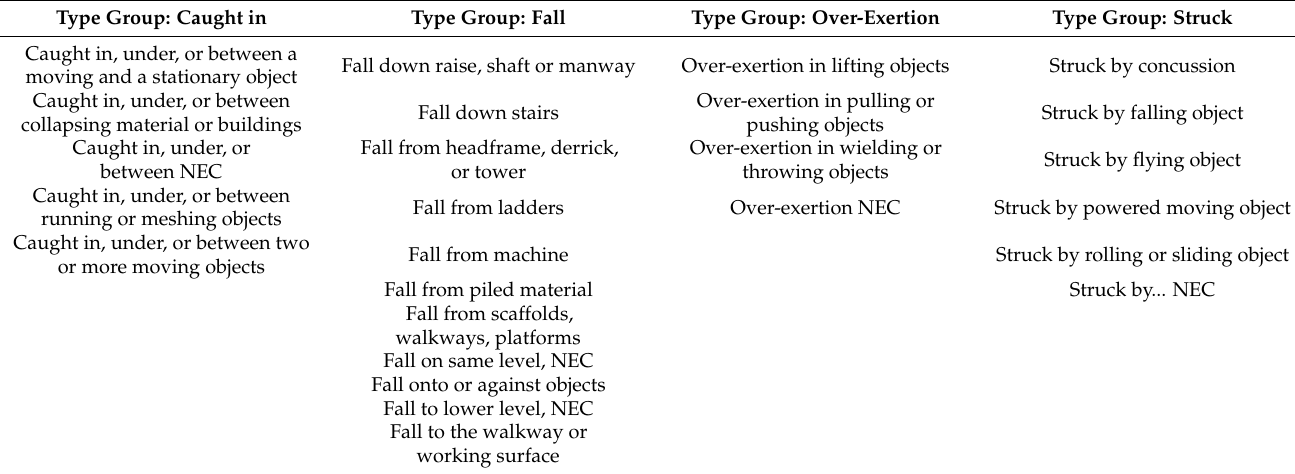
Table 1. The four type groups of accidents modeled in the